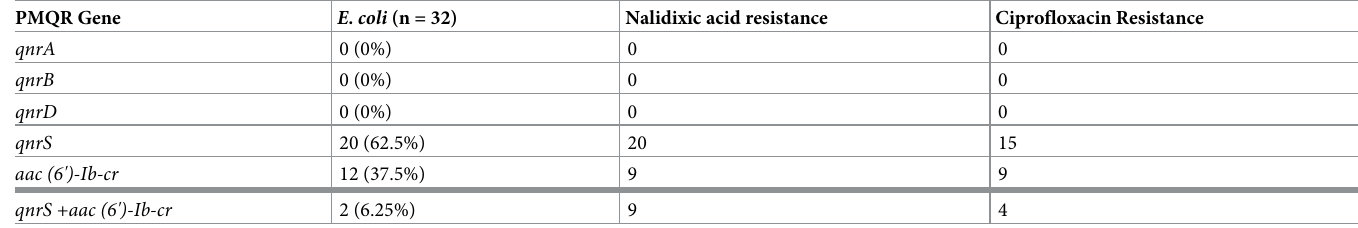
Table 6. Frequency of PMQR genes among quinolone-resistant, ESBL-positive E . coli . PMQR